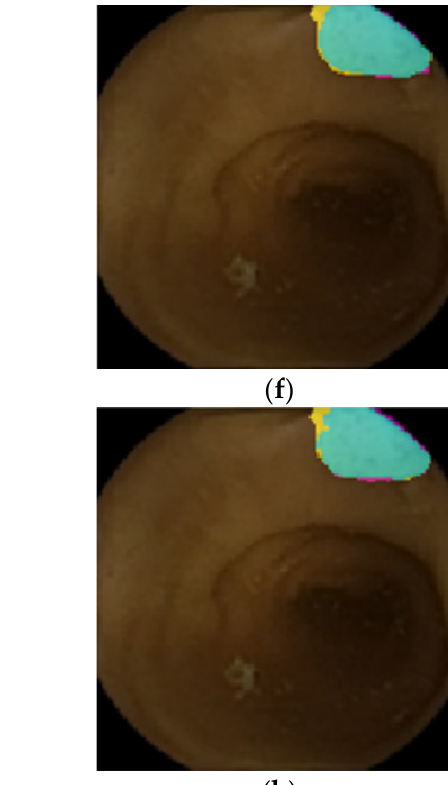
Table 4. Comparative results between U-Net with depth 4, AID-U-Net (3, 1) and AID-U-Net (2, 2) applied to images of colon capsule endoscopy (CCE) for colorectal polyp